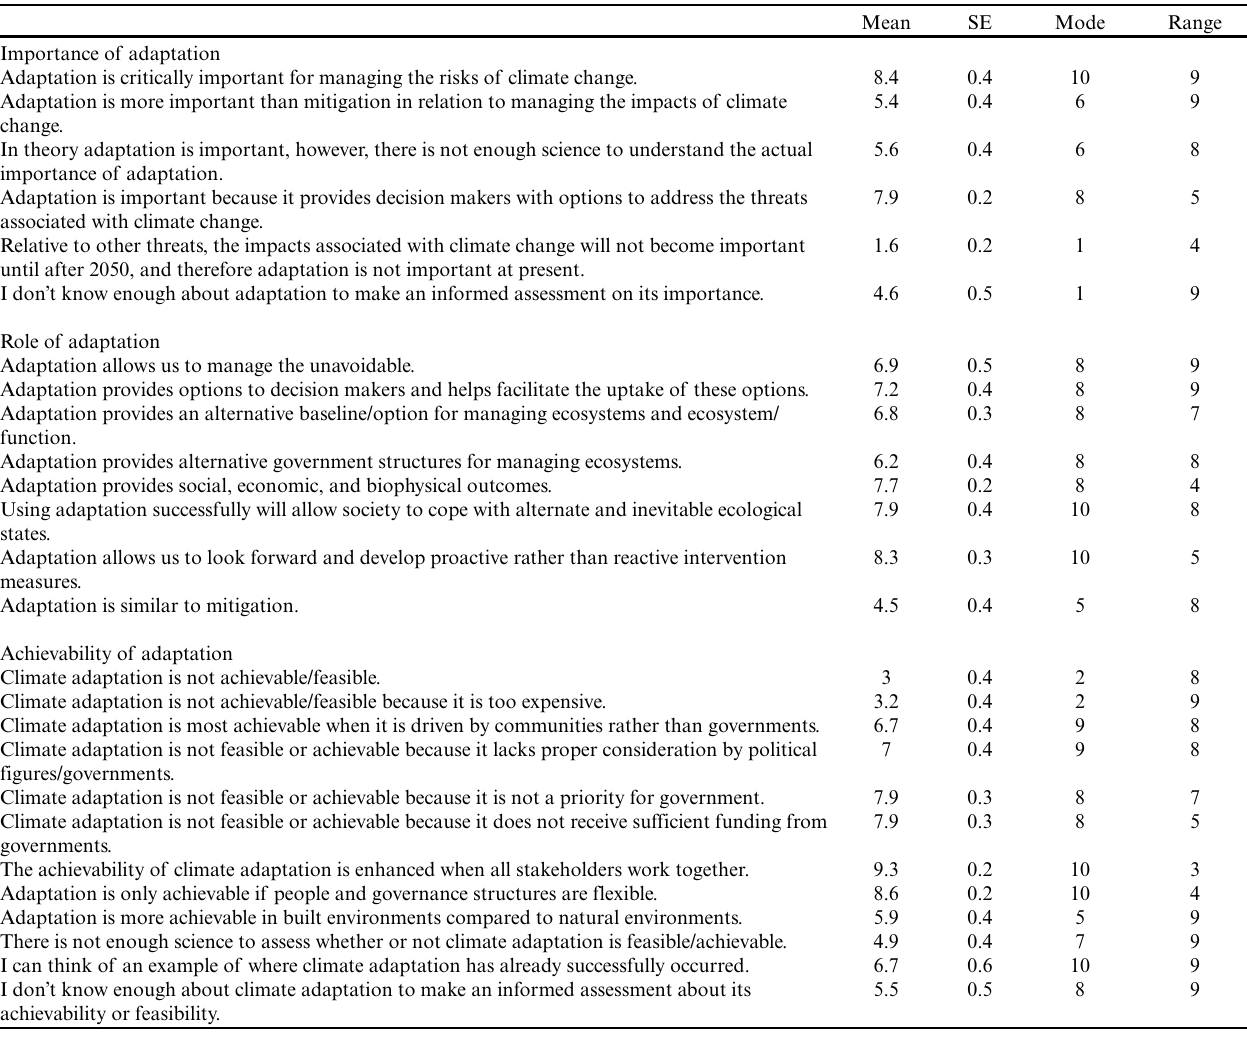
Table 2 . Perceptions of Australian marine protected areas (MPA) decision makers (n = 30) about the importance, role, and achievability of adaptation for managing the risks of climate change. Scores are based on a Likert scale between 1 and 10, where a score of 1 indicated that the participant strongly disagreed with the statement, whereas a score of 10 meant that the participant strongly agreed with the statement.